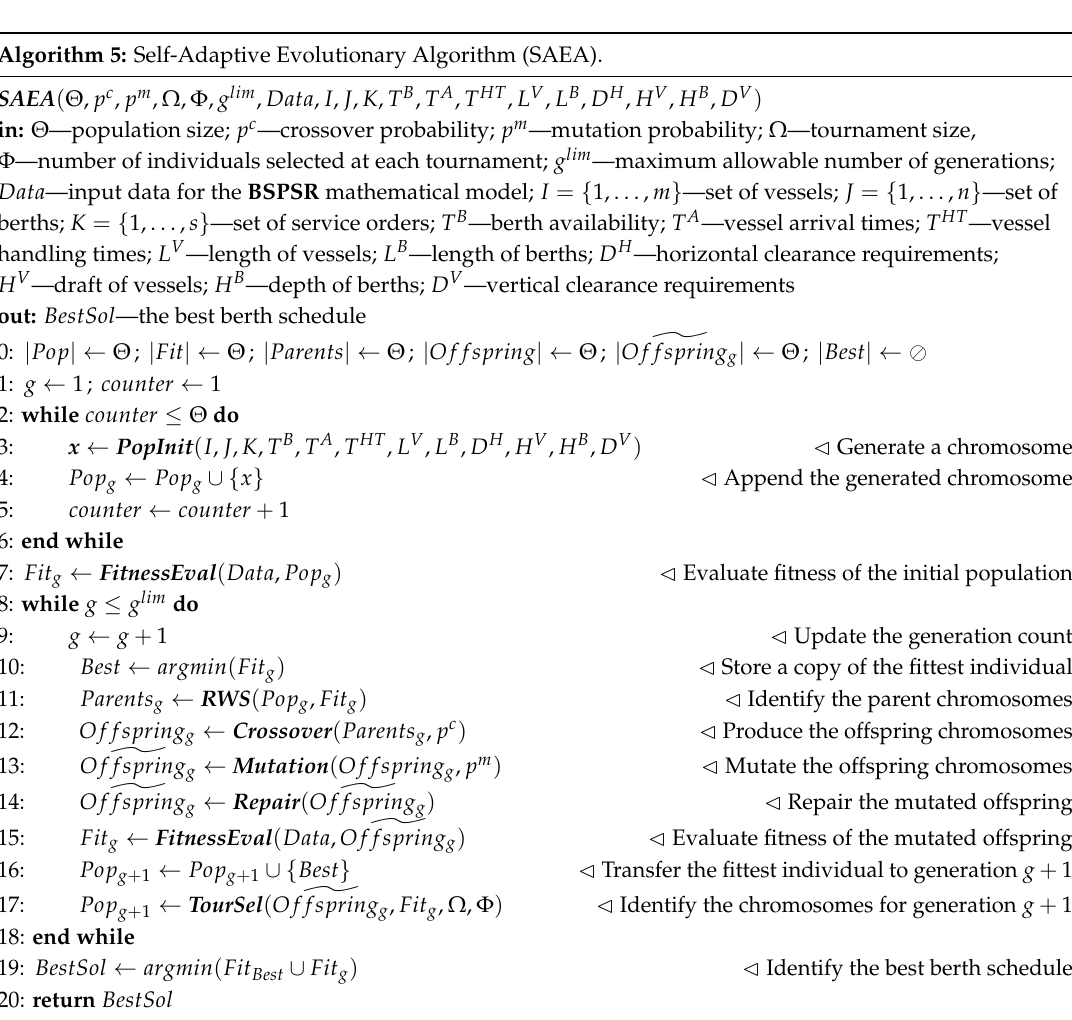
Algorithm 5: Self-Adaptive Evolutionary Algorithm